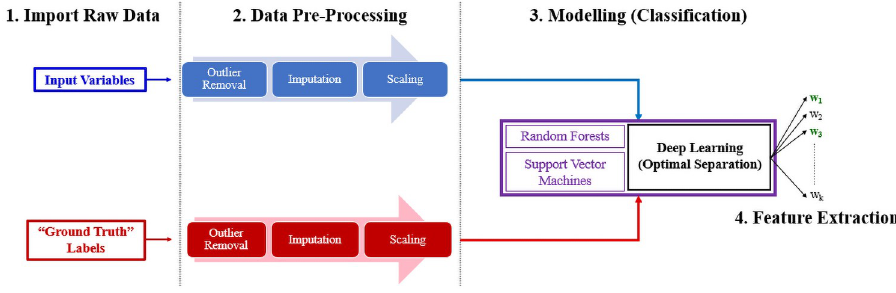
Fig 1. Overall data analysis workflow in block diagram form. (Step 1) : The collection of raw input data samples, as well as a corresponding set of labelled “ground-truth” targets. (Step 2) : The pre-processing of raw input data into suitable structures for modelling, guided by any available domain or expertise knowledge. (Step 3) : The training of several types of classification models (including Deep Learning), which maps inputs to their corresponding discrete class labels. (Step 4) : The design of special objective function within a Deep Learning classification, which identifies a latent space with improved class separation. The most dominant latent features are then distinguished by the magnitude (ex. ℓ 2 norm) of the neural network